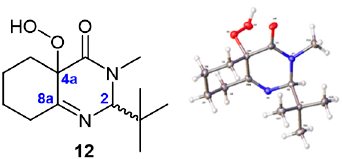
ff raction of hexahydroquinazolinone ( 12 ). It should be Figure 2 . Structure and single-crystal X-ray diffraction of hexahydroquinazolinone ( 12 ). It should be Figure 2. Structure and single-crystal X-ray di